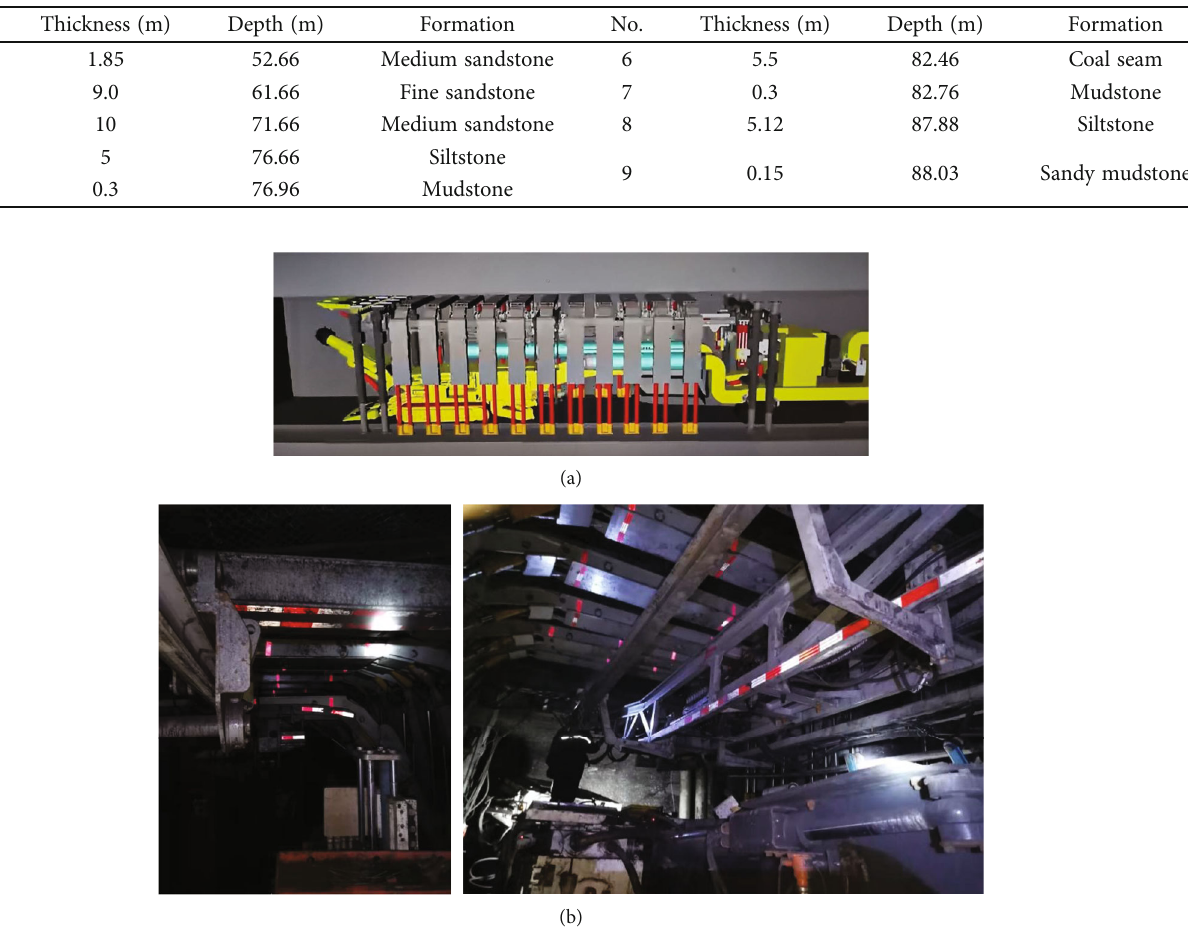
Figure 1: Hydraulic door bracket. (a) Renderings of hydraulic door-type bracket. (b) Photo of the hydraulic gate bracket.